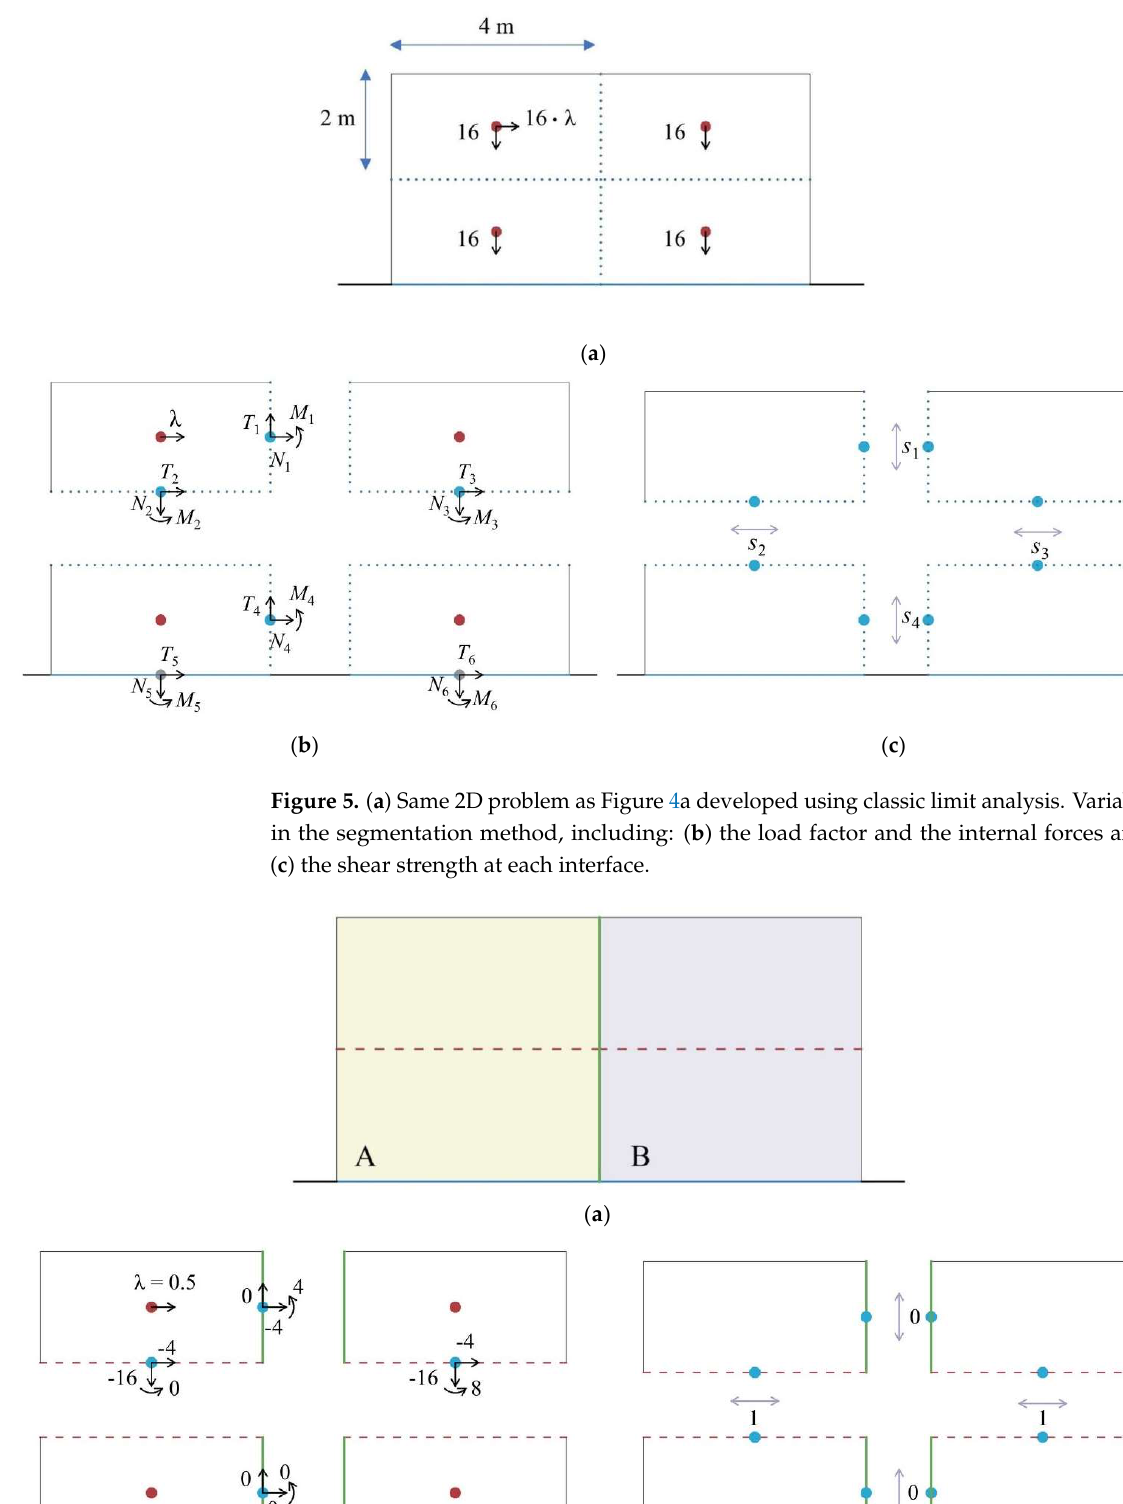
(e) Figure 7. ( a , b ) Two subsets of initial input interfaces for complex geometries; ( c ) a set of internal and peripheral interfaces generating ( d ) invalid and ( e ) valid segments. Furthermore, a set of internal and peripheral interfaces obtained by the optimization algorithm should generate a meaningful segmental model. For example, the peripheral interfaces should be able to model an individual block (Figure 7b). However, introducing geometric constraints to the optimization is beyond the scope of this paper and will be taken into consideration in future research. In the next section, the same optimization concept will be developed based on the discontinuity layout optimization (DLO) method, which is highly mesh-independent compared to limit analysis.